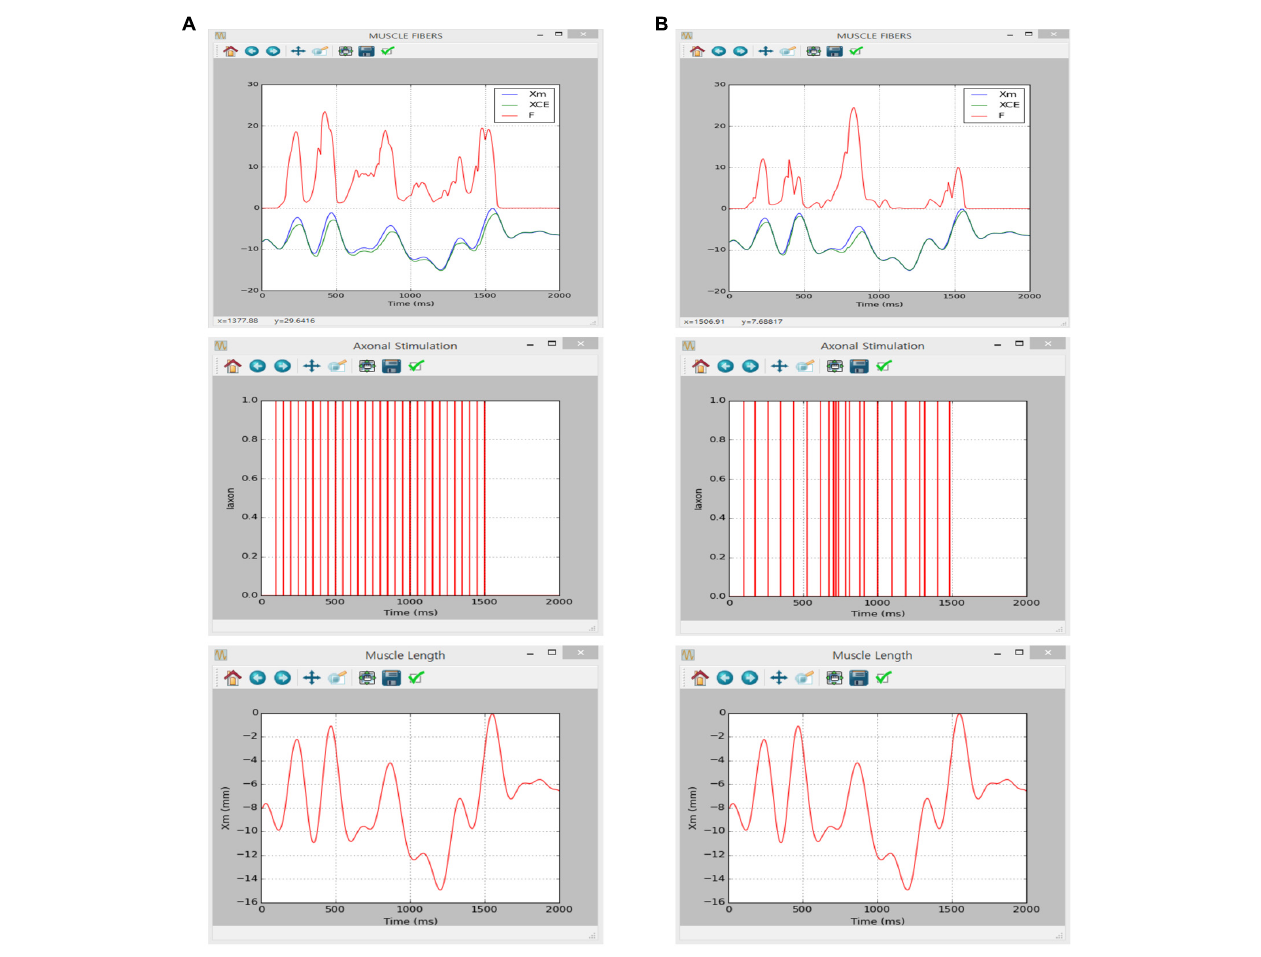
FIGURE 7 | Non-linear input–output behavior of the cat soleus muscle. (A) Muscle force (F, upper panel) and length of the contractile element (X CE , upper panel) in response to a train of current impulses with a constant frequency of 20 Hz over the axon (I axon , middle panel) during locomotor-like movement (X m , bottom panel). (B) Muscle force (F, upper panel) and length of the contractile element (X CE , upper panel) in response to a train of current impulses with a random frequency with an average of 20 Hz over the axon (I axon , middle panel) during locomotor-like movement (X m , bottom panel).